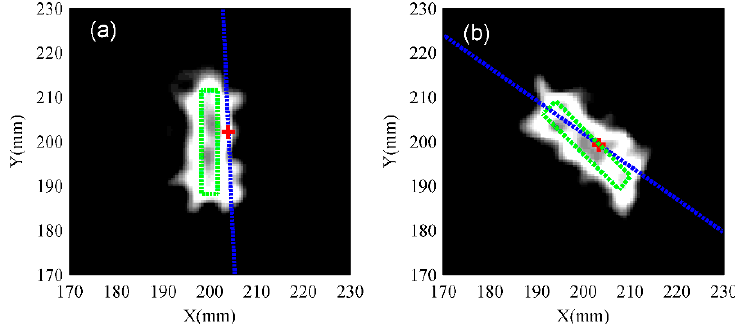
Figure 22. The direction identification of an inclined rectangular groove based on the experimental result. ( a ) 90°; ( b ) 135°. The red plus (+) indicates the centroid location. The blue dashed line is the spindle. The green dash line is boundary of the inclined rectangular groove. The background image is a grayscale image which is processed by a threshold at the level of − 3 dB.